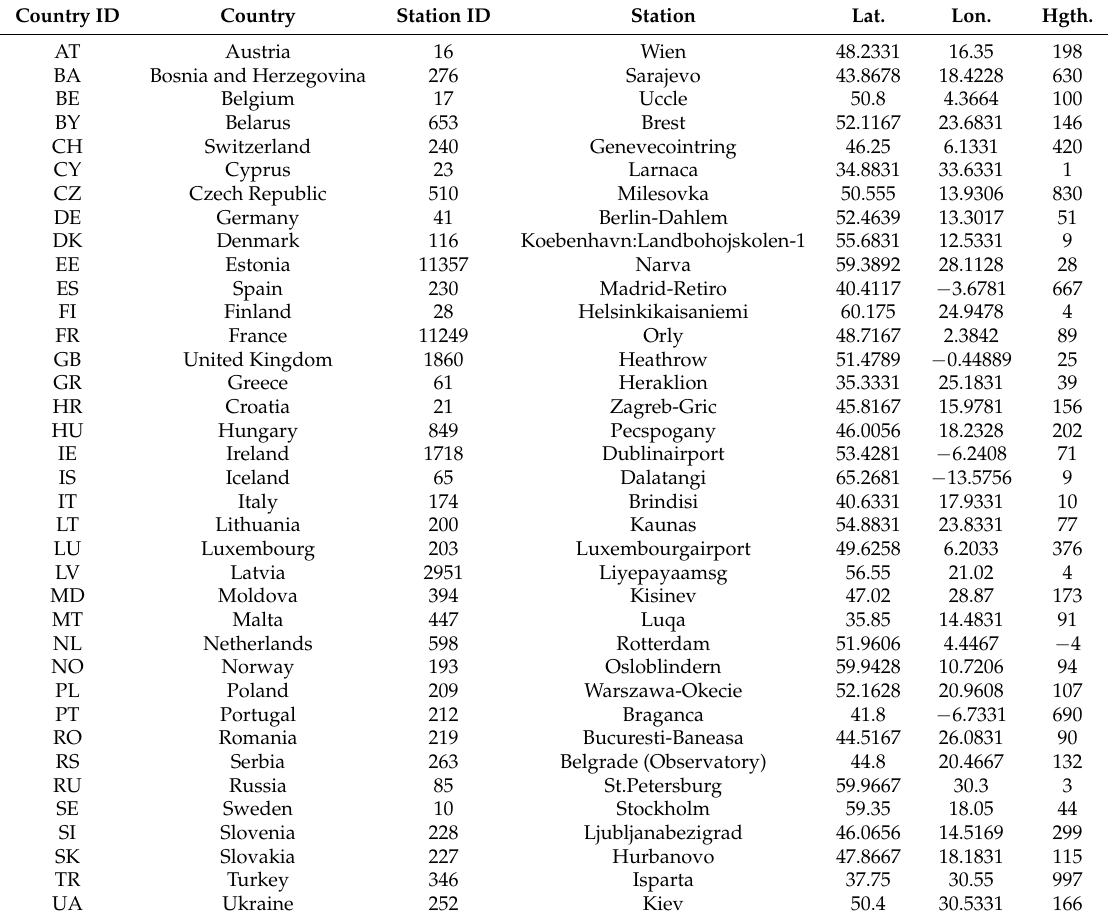
Table A1. Detail of the European weather stations used for each country. Country